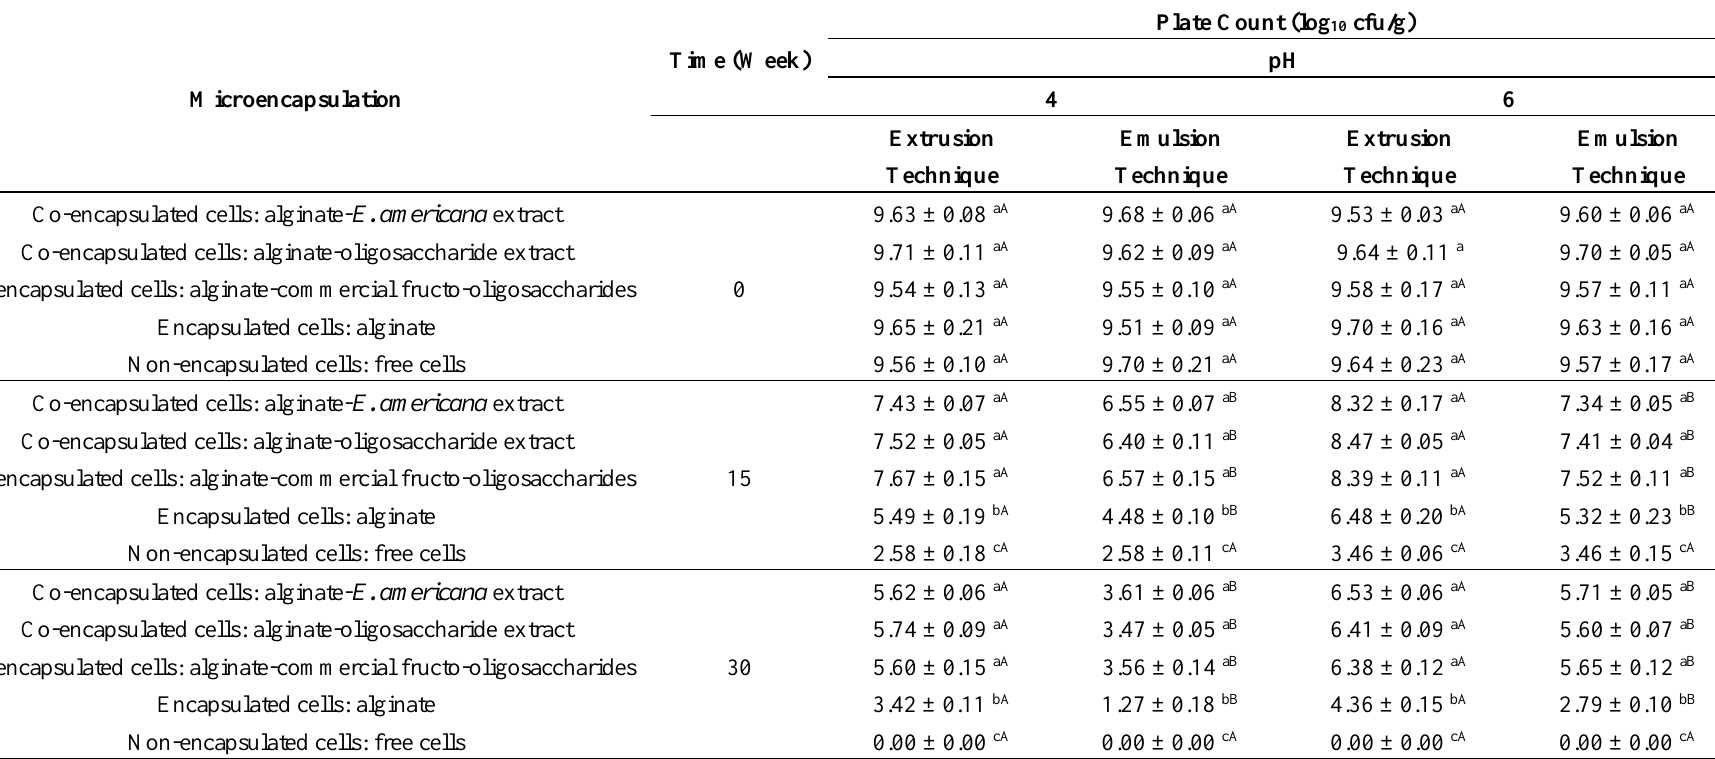
Table 5. Survival of microencapsulated Bifidobacterium longum with Eleutherine americana under heat